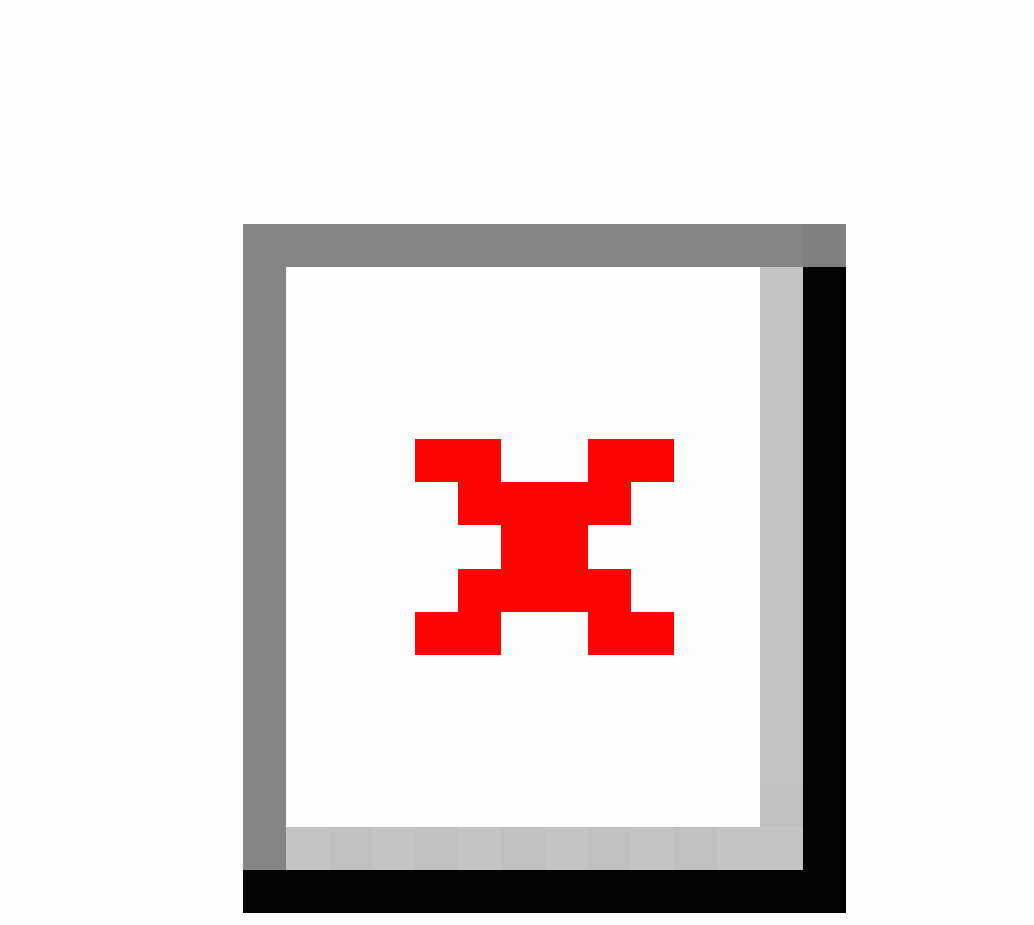
Figure 2. Area under the curve (AUC) of the receiver-operator characteristic (ROC) curve for increasing numbers of Turker interpretations of a prototypical image from each severity level. Turkers had low accuracy for the Mild (Panel A) and Severe image (Panel C), but acceptable accuracy for the Moderate image (Panel B). When all four images were analyzed for absence or presence of disease only, Turkers performed well (Panel D) with a highly significant